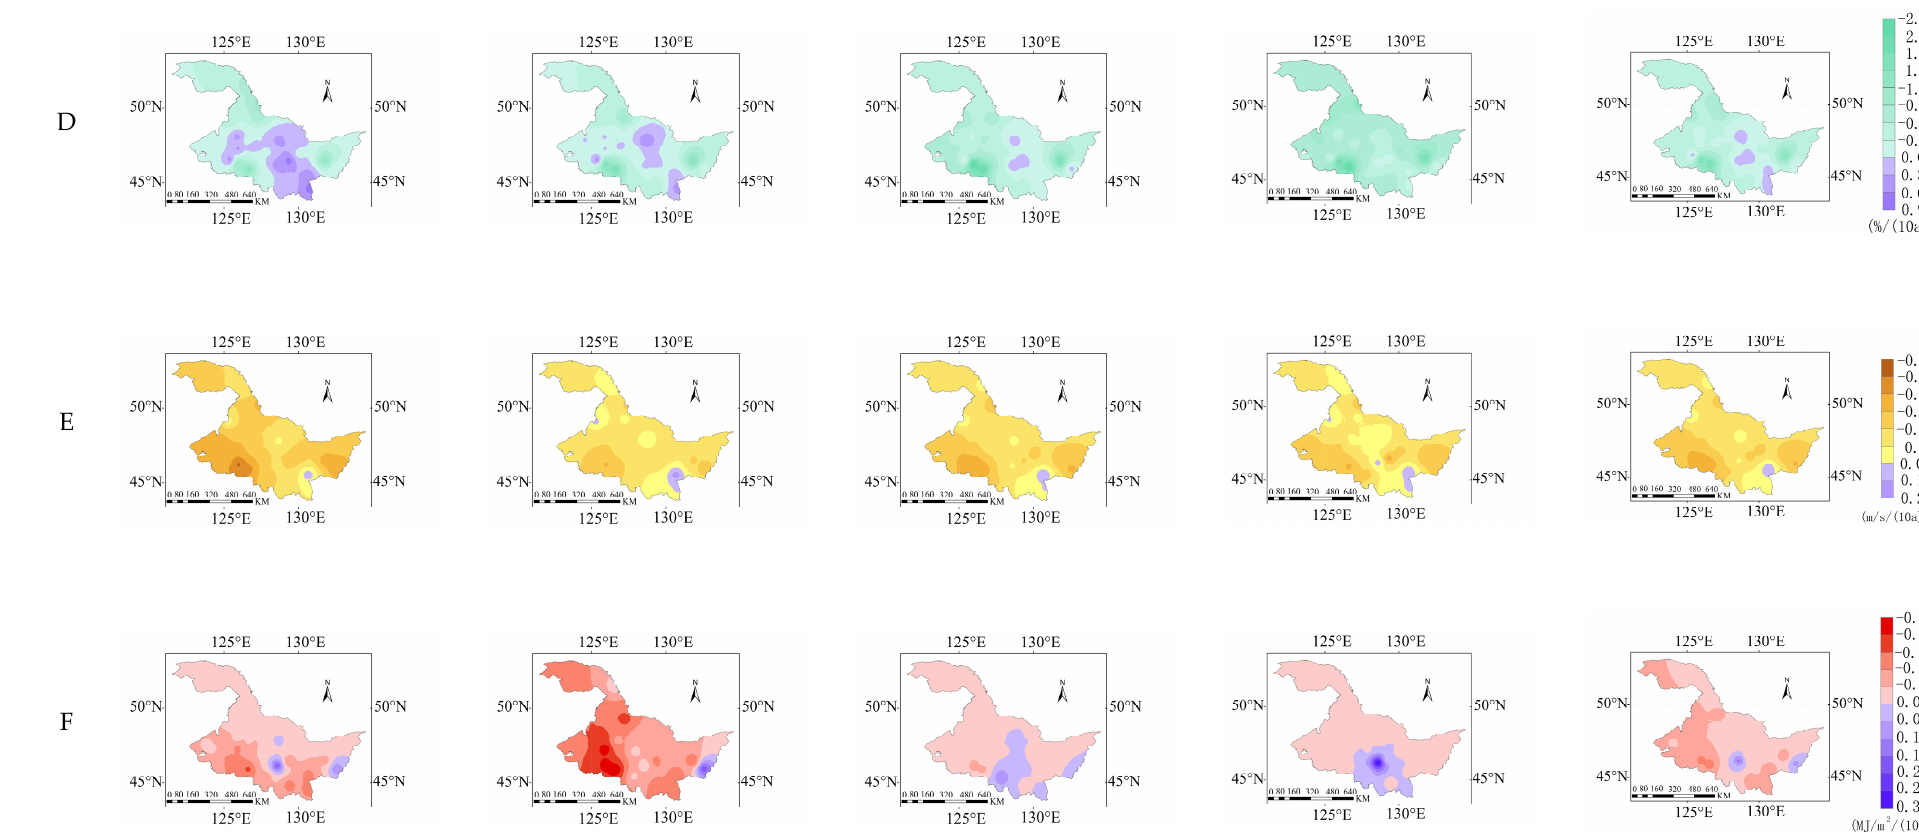
Figure 3. Climatic tendency rate of ( Row A ) T max , ( Row B ) T min , ( Row C ) T mean , ( Row D ) RH , ( Row E ) U , ( Row F ) Rn from 1960 to 2019.